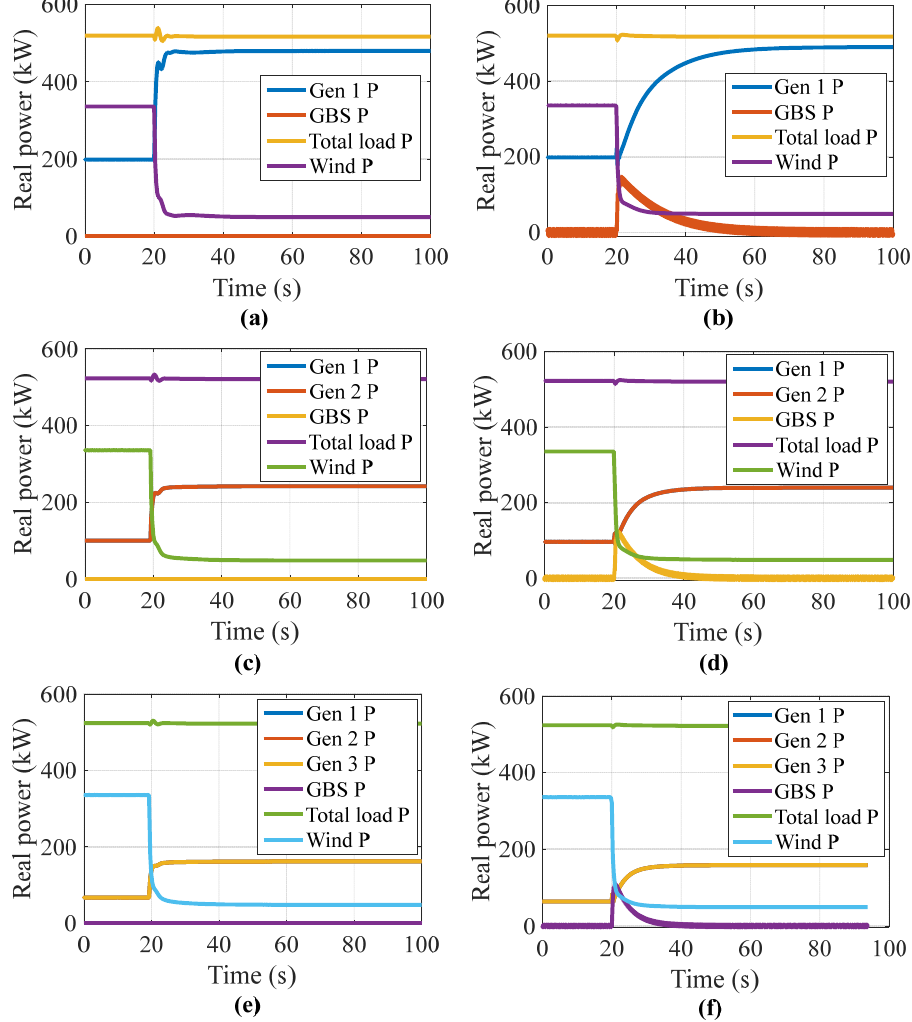
Figure 14. Active Power Traces for Different Generator Cases with a Loss of Wind Scenario. ( a ) One Diesel generator. ( b ) One diesel generator and a grid-forming inverter. ( c ) Two diesel generators. ( d ) Two diesel generators and a grid-forming inverter. ( e ) Three diesel generators. ( f ) Three diesel generators and a grid-forming inverter.